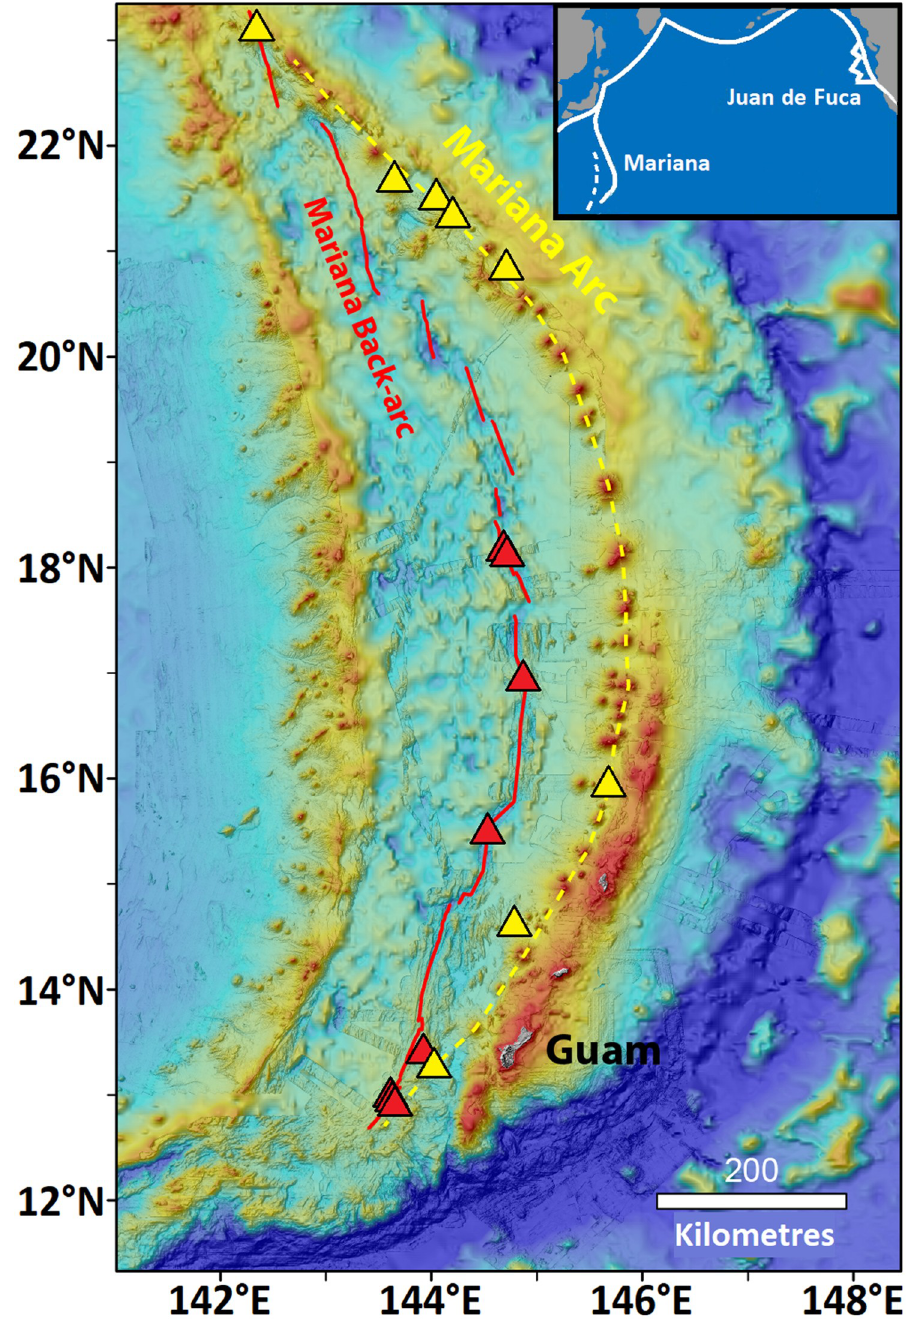
Fig 1. Map of the Mariana region and its known hydrothermal vent sites. The Mariana tectonic region includes back-arc and volcanic arc vent systems. The red and yellow lines trace the back-arc and arc respectively, and coloured triangles indicate locations of hydrothermal vent sites in this study. From north to south, the red triangles represent Alice Springs/Illium, Burke (overlapping), Hafa Adai, Perseverance, Forecast, then Snail, Archaean and Urashima/Pika (overlapping). From north to south, the yellow triangles represent Nikko, Kasuga-2, NW Eifuku, Daikoku, Chamorro, E Diamante, NW Rota and Seamount X. The last site lies only 20 km from Forecast. Inset shows locations of the Mariana and Juan de Fuca vent systems in the North Pacific. Map produced by WW Chadwick using data from GEBCO (British Oceanographic Data Centre) and from NOAA surveys.